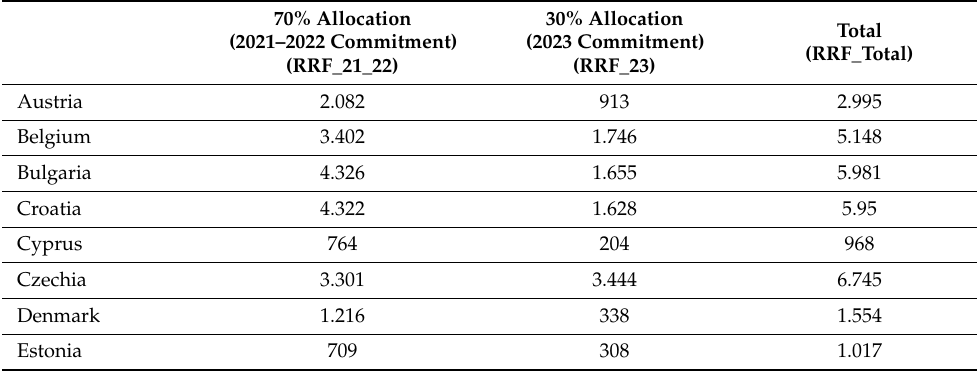
Table 4. RRF—Grants allocation per Member State (in million EUR 2018